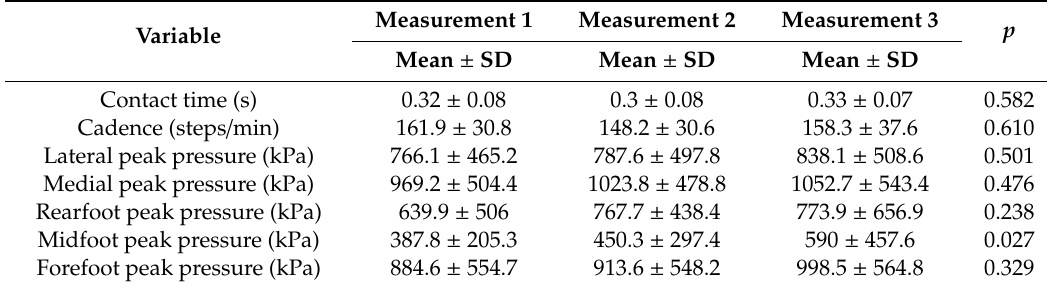
Table 1. Plantar pressures in the three stages of the study.